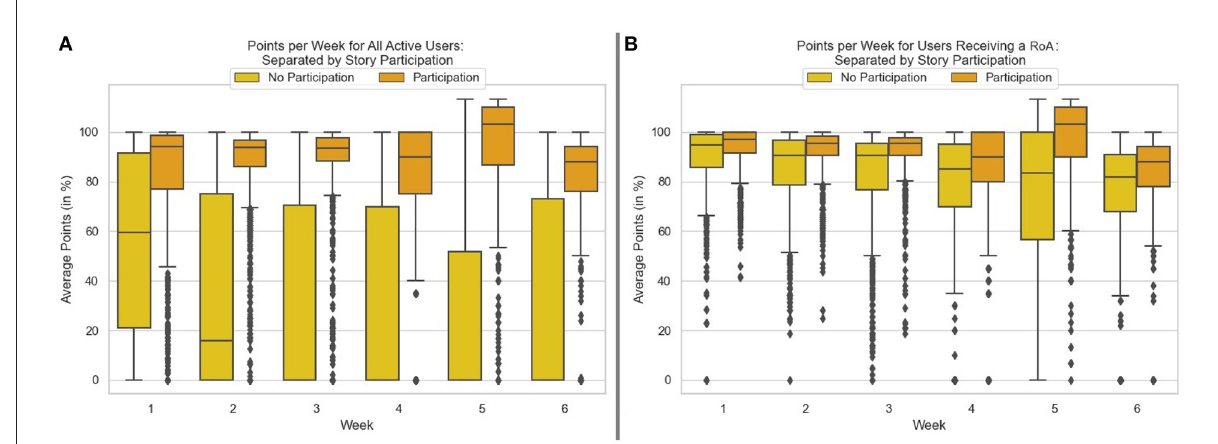
FIGURE8 Weekly performance for users participating with the story (orange) or skipping the story (yellow). Left (A) : All active users in the course including users not receiving a course certificate; course dropouts lead to a median of 0 from week 3 onward. Right (B) : Only those users that received a Record of Achievement (and a CoP simultaneously, similar to Figure 6B); median of users participating in the story is higher for all course weeks compared to no story